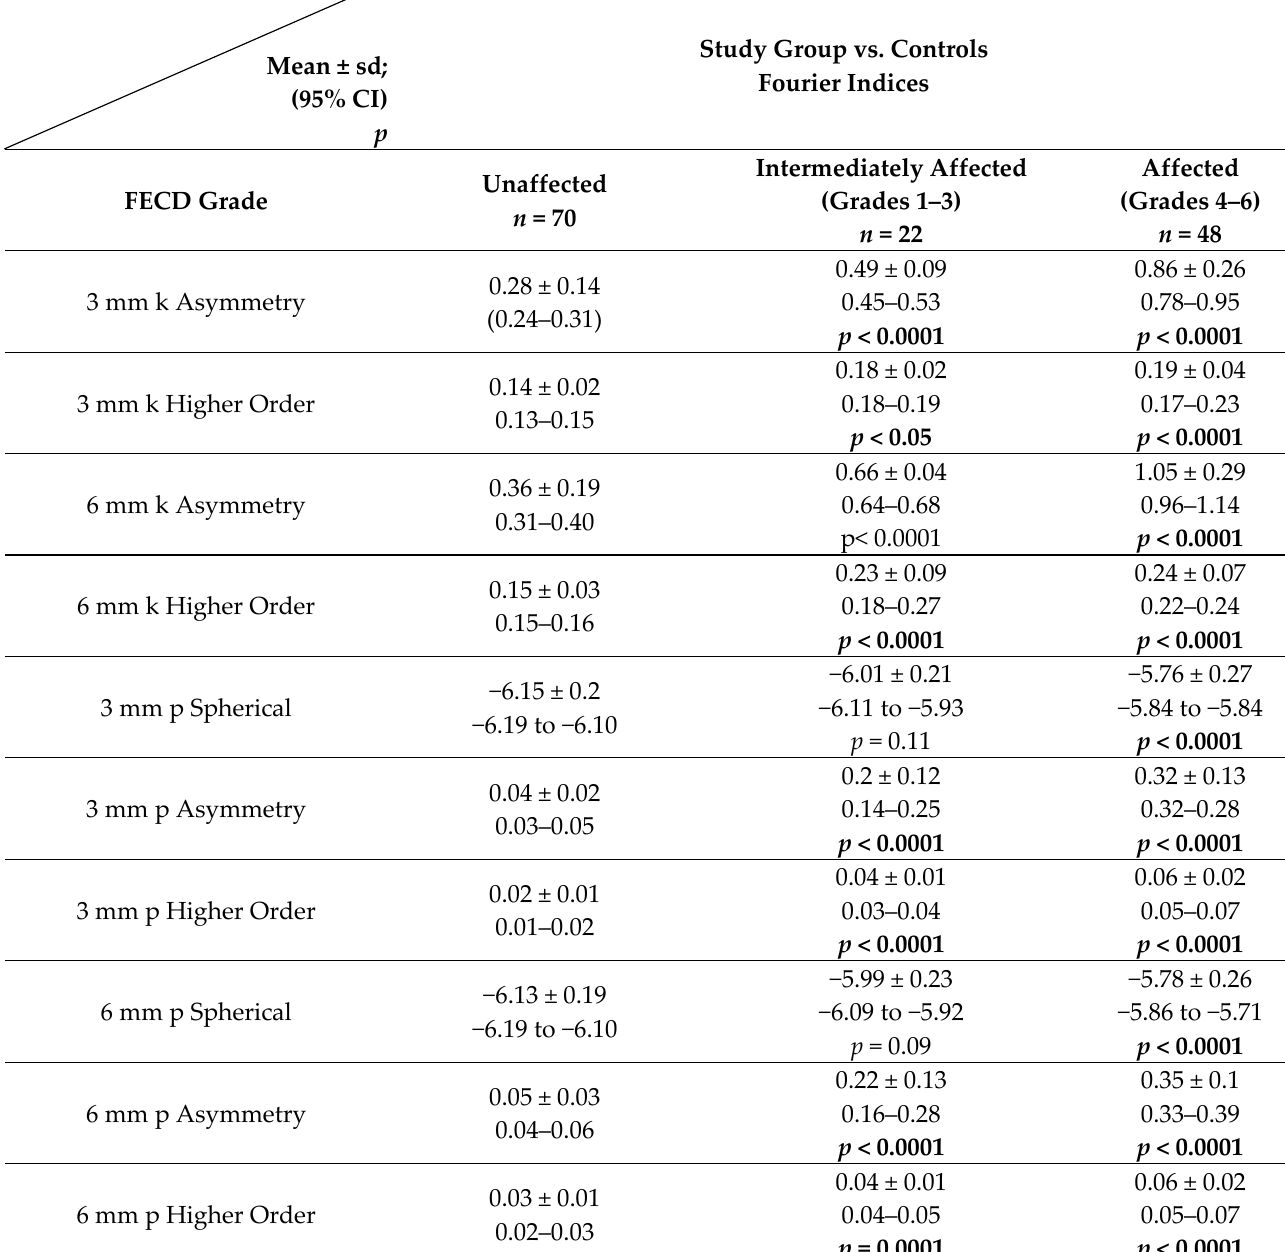
Table 5. Comparison of Fourier indices of the intermediately affected, affected, and unaffected eyes.